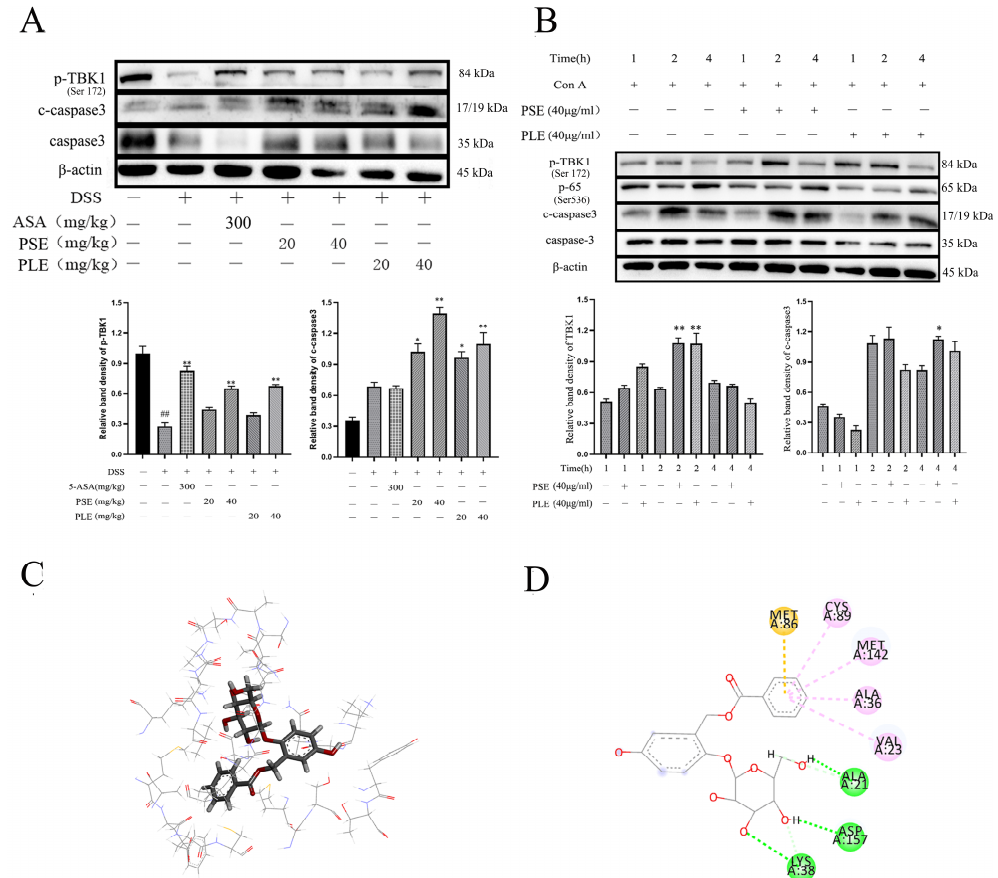
Figure 8. PSE and PLE may induce the apoptosis of lymphocytes through STING-TBK1 pathway. ( A ) The protein levels of p-TBK1 and c-Caspase3 in the spleen tissue of DSS-induced IBD mice were examined by Western blot. Band intensities of Western blots were normalized to actin and quantified by densitometry. ( B ) Lymphocytes were incubated with 4 µ g/mL Con A and different concentrations of PSE and PLE at 37 °C for 1 h, 2 h or 4 h. The protein levels of p-TBK1, NF-κB and c-Caspase 3 were detected by Western blot. Band intensities from Western blot were normalized to actin and quantified by densitometry. ( C , D ) Induced-fit docking analysis of the interaction between salireposide and TBK1 protein. Hydrogen bonds and π-π stacks are indicated by green and pink dotted lines, respectively. The “+” indicates that the substance (3.5% DSS or 4 μg/mL Con A) was added, and the “–” indicates that the substance was not added. ## P ＜ 0.01 vs. Control (Ctrl) , * p < 0.05, ** p < 0.01 vs. model group .